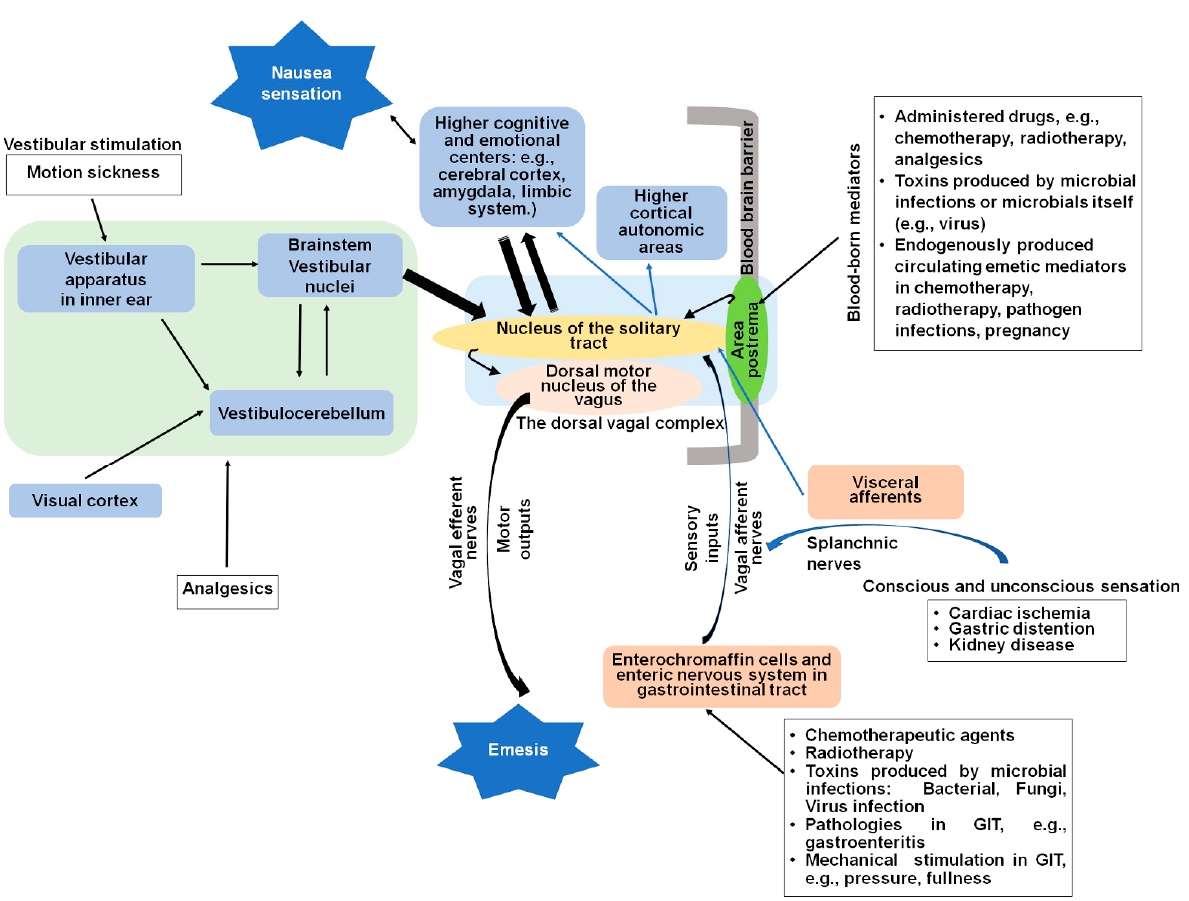
Figure 1. Central and peripheral anatomical sites involved in nausea and vomiting induced by various stimuli. Nausea and vomiting can be generated by diverse stimuli and are mediated by the bidirectional interaction between brain and gut. In brief: (1) The brainstem area postrema in the floor of the fourth ventricle lacks blood brain barrier and thus serves as direct central receptor sites for circulating and systemic emetic stimuli in the cerebrospinal fluid and the blood [11]. (2) Systemically administered drugs can activate corresponding receptors present on vagal afferents, which project sensory signals to the nucleus of the solitary tract [11,12]. (3) Peripheral stimuli such as toxic drugs and microbials (e.g., bacteria, viruses, fungi) that enter the lumen of the gastrointestinal tract (GIT) and pathologies in the GIT cause release of local emetic neurotransmitters/modulators, which subsequently act on the corresponding receptors present on vagal afferents and/or stimulate the brainstem area postrema via circulating blood [9,10]. Besides the area postrema and the sensory vagal afferents, the nucleus of the solitary tract is also the recipient of: (i) direct neural inputs from the splanchnic nerves carrying sensation caused by diseases of visceral organs (e.g., cardiac, kidney); (ii) brainstem vestibular nuclei collecting signals from vestibular apparatus in inner ear and/or cerebellum, caused by stimuli related to motion sickness and opioid analgesics [13,14]; and (iii) the cerebral cortex and limbic system, which accept and process emotional and cognitive stimuli [3–8]. The nucleus of the solitary tract has output pathways to the dorsal motor nucleus of the vagus, which further project to the upper gastrointestinal tract to produce the vomiting reflex [11]. In addition, the nucleus of the solitary tract has projections to the mid- and forebrain for the perception of nausea